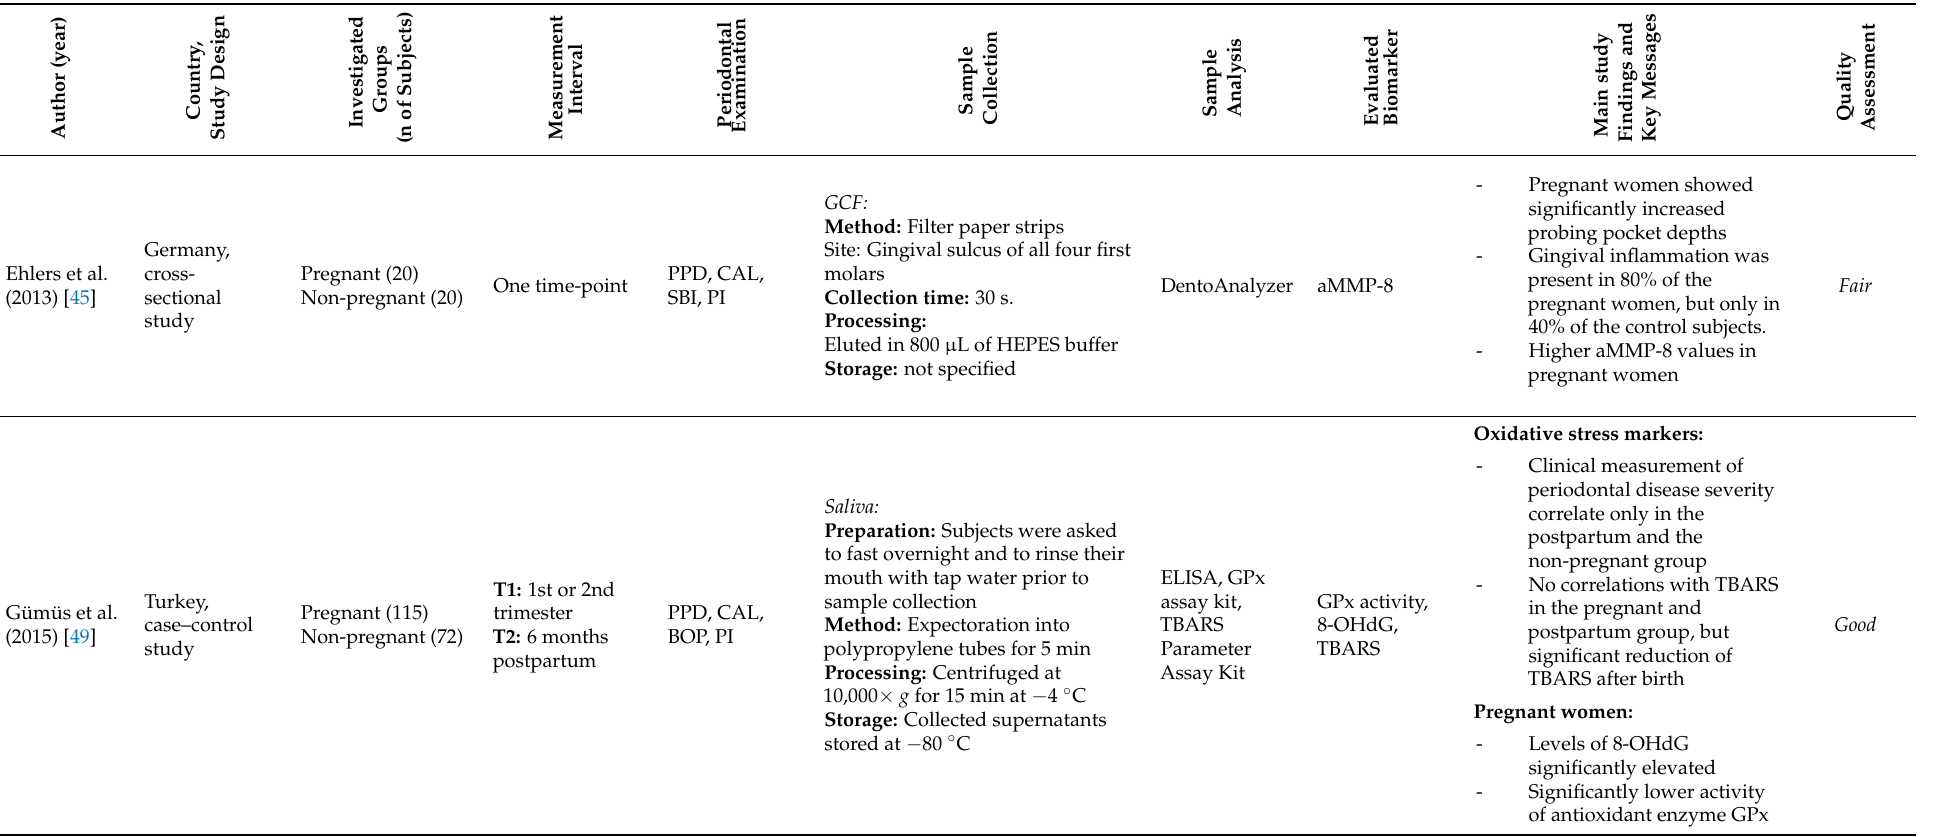
Table 2. Differences in inflammatory responses in oral biofilm between healthy pregnant and non-pregnant